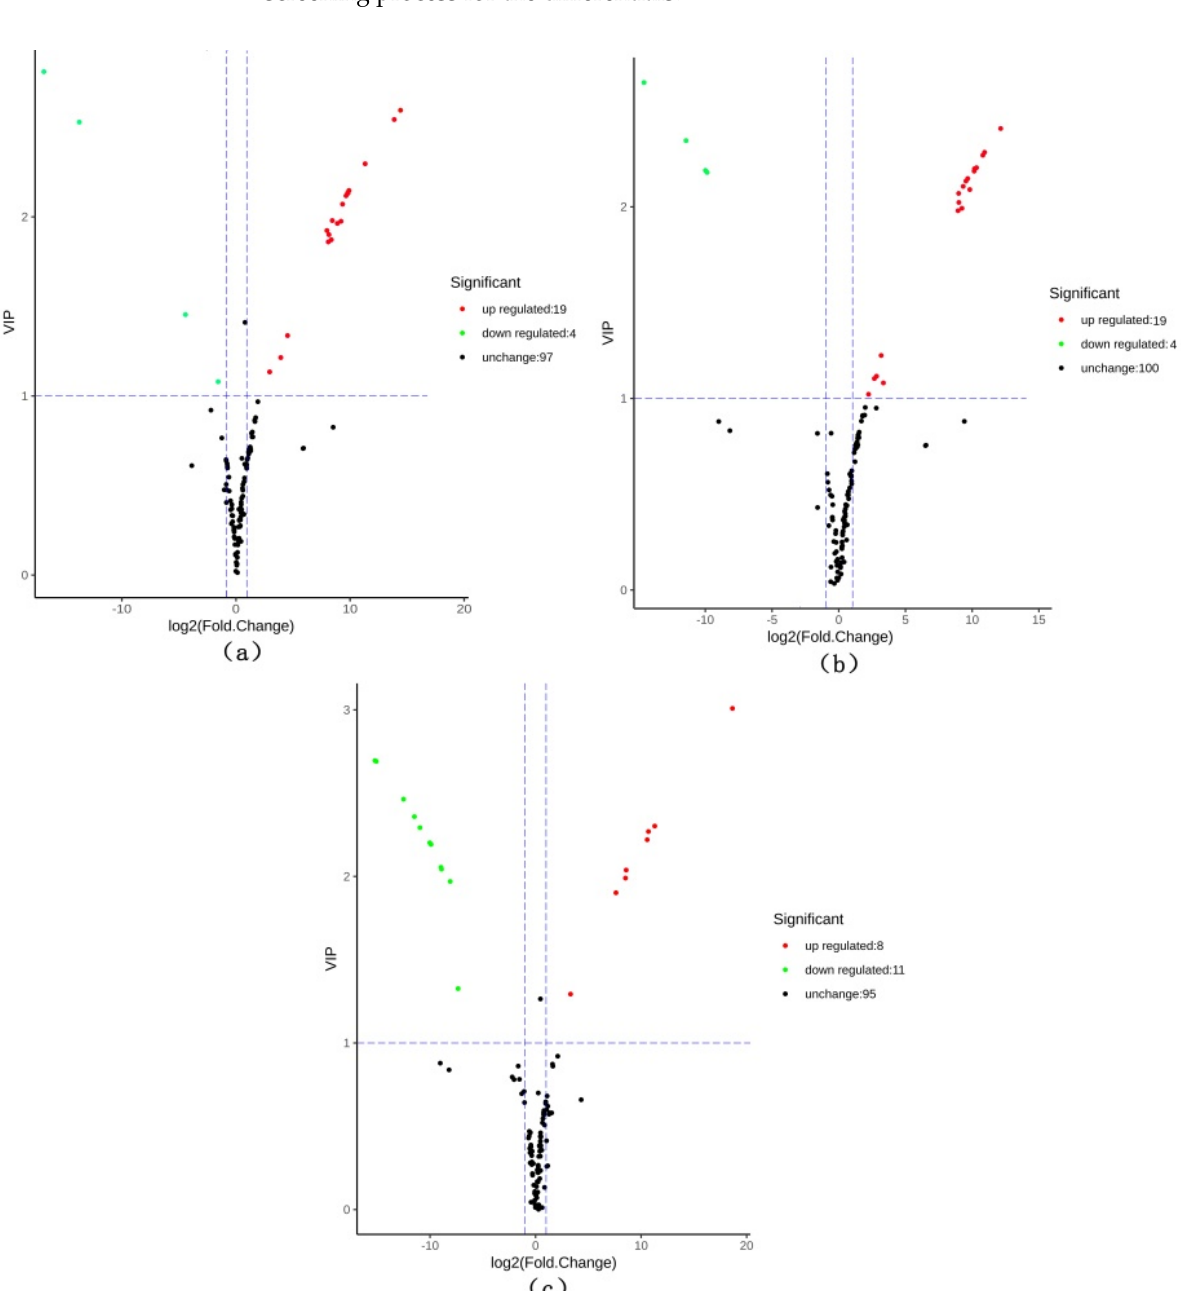
11 different metabolic compounds, indicating that these 11 components were characteris- tic of CSG where the relative content of 10 metabolites was upregulated (Table 1). There was only one component in the intersection of all the groups, indicating that there were large differences in the differential metabolites of each sample. The KEGG classification